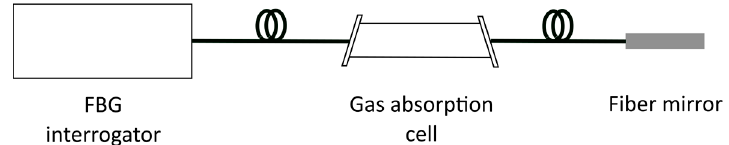
Figure 3. Setup of the second calibration method, based on calibrated absorption gas cells.